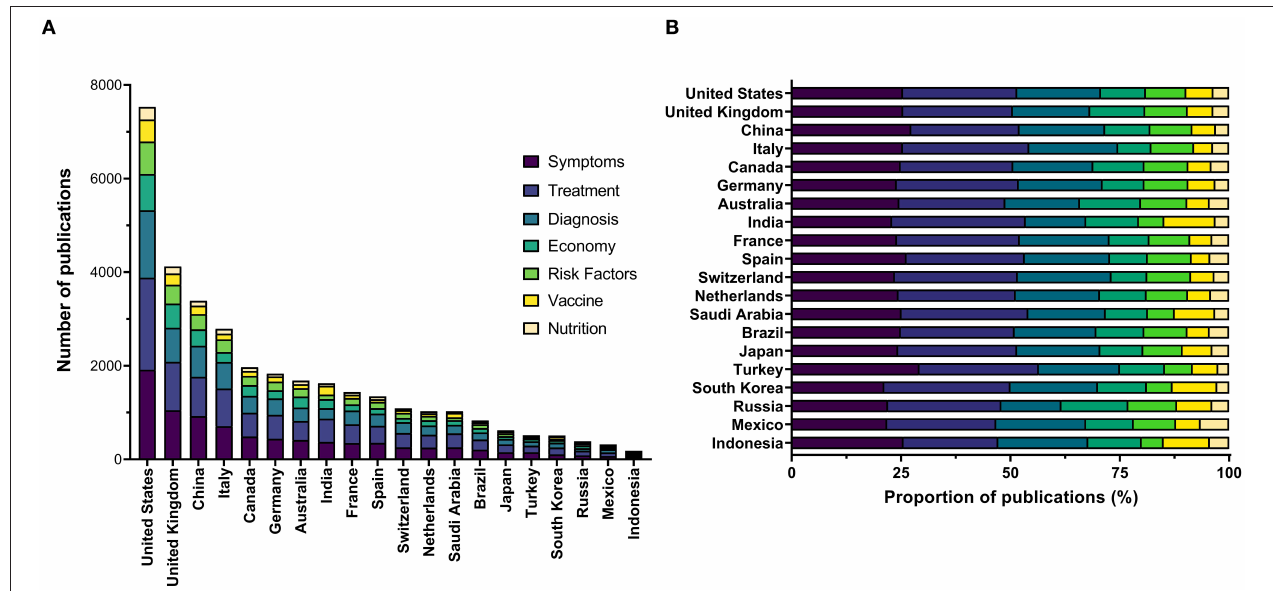
FIGURE 4 | Total number (A) and proportion (B) of early publications involving authorships from multiple countries on COVID-19 from the 20 highest-ranked countries according to gross domestic product.